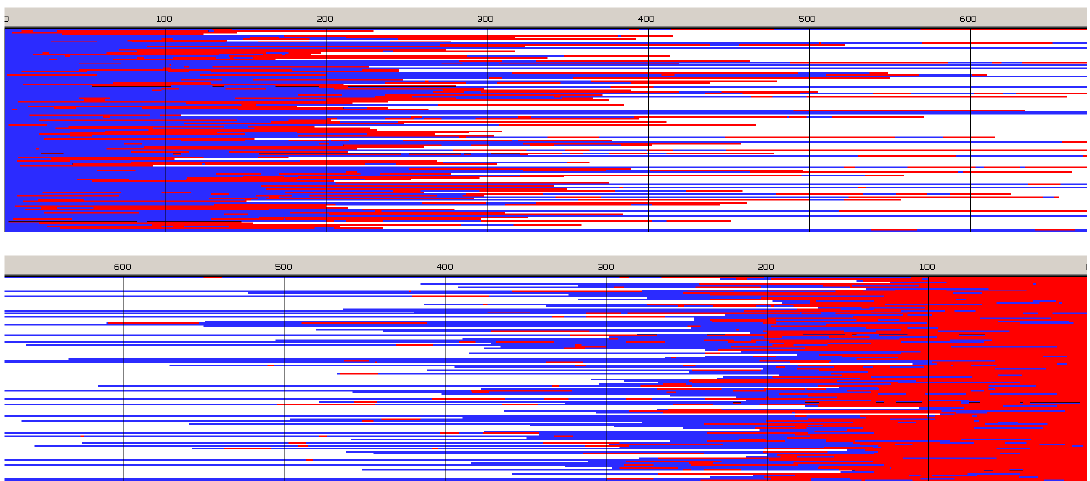
Figure 6. Sample of simulated chains in copolymerization initiated with Tmc -R - Ini *. Reactivity